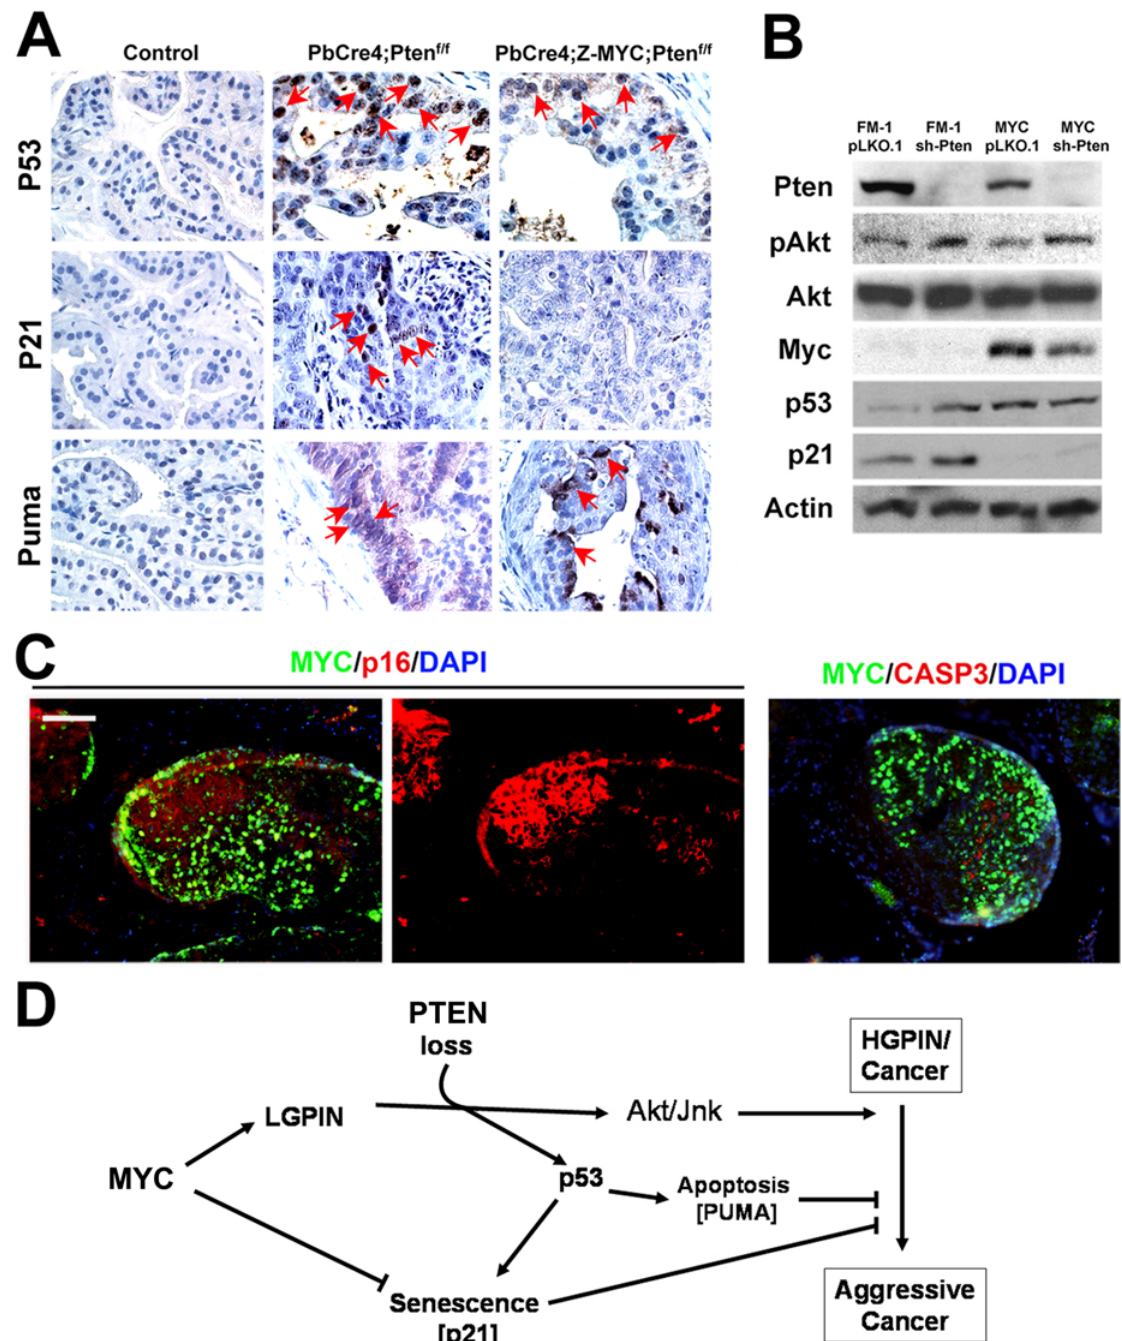
Figure 7. c-MYC and p53 pathway status in c-MYC/Pten mutant prostate cells. (A) Immunohistochemistry for p53, p21 and Puma. Prostate sections from mice of the indicated genotypes were stained with the indicated antibodies and nuclei were counterstained with hematoxylin. Positive cells (brown) are indicated by red arrows. (B) Western blots show expression of the indicated proteins in RWPE-1 cells expressing c-MYC, PTEN knockdown, or control vectors (FM-1, pLKO.1). PTEN and phospho-Akt (pAkt) blots confirm efficiency of PTEN knockdown. (C) Double immunofluorescent stains for c-MYC/p16 and c-MYC/activated Caspase 3 in PbCre4;Z-MYC;Pten f/f prostates. Scale bar: 100 m m. (D) Model of interactions between c-MYC and Pten with the p53 pathway in c-MYC–initiated prostate cancer. Focal c-MYC overexpression leads to LGPIN and facilitates loss of Pten leading to HGPIN/invasive cancer. Activation of the p53 pathway due to Pten loss could lead to senescence or apoptosis. c-MYC expression is proposed to shift this response towards apoptosis by repressing p21 expression.